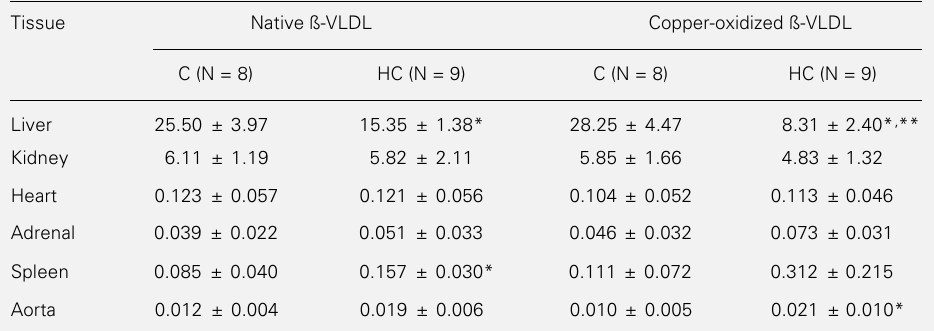
Table 4 - Biodistribution of 99m Tc-ß-VLDL in rabbits (% injected dose/organ). Data are reported as means ± SD of results obtained from (N) rabbits. C = Control rabbits; HC = hypercholes- terolemic rabbits. *P<0.05 compared to the respective control group; **P<0.05 compared to native ß-VLDL of the HC group (ANOVA and Scheffé